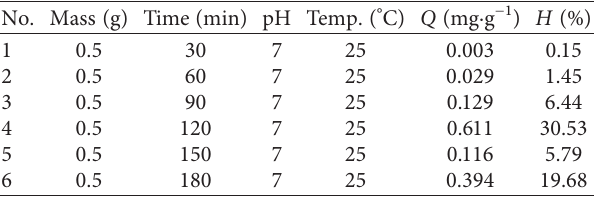
Table 7: Effect of adsorption time on the Cr (VI) ion adsorption process.